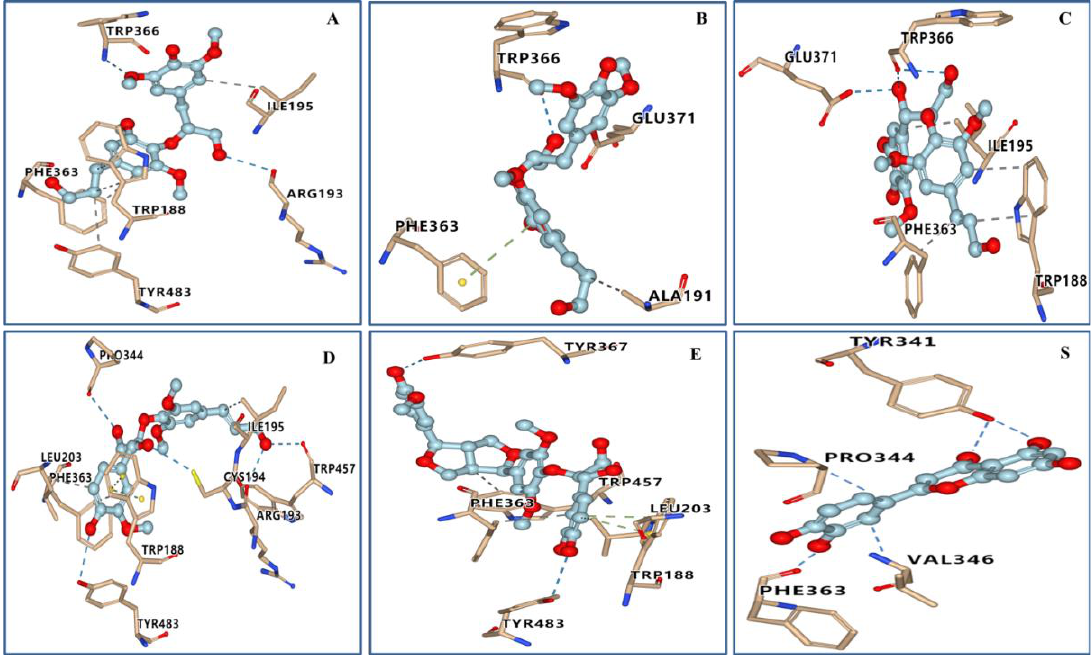
Figure 5. Molecular docking simulations of compounds 1a ( A ), 1b ( B ), 5 ( C ), 6 ( D ), 7 ( E ) and quercetin ( S ) with the iNOS protein. Table 3. Docking results of active compounds with the iNOS protein.